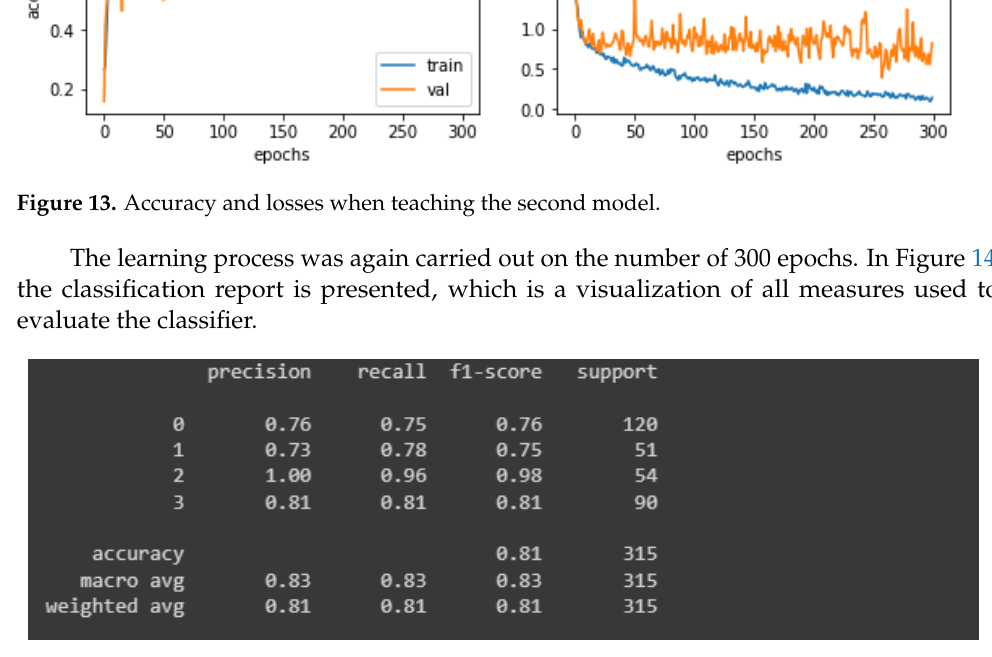
Figure 13. Accuracy and losses when teaching the second model.